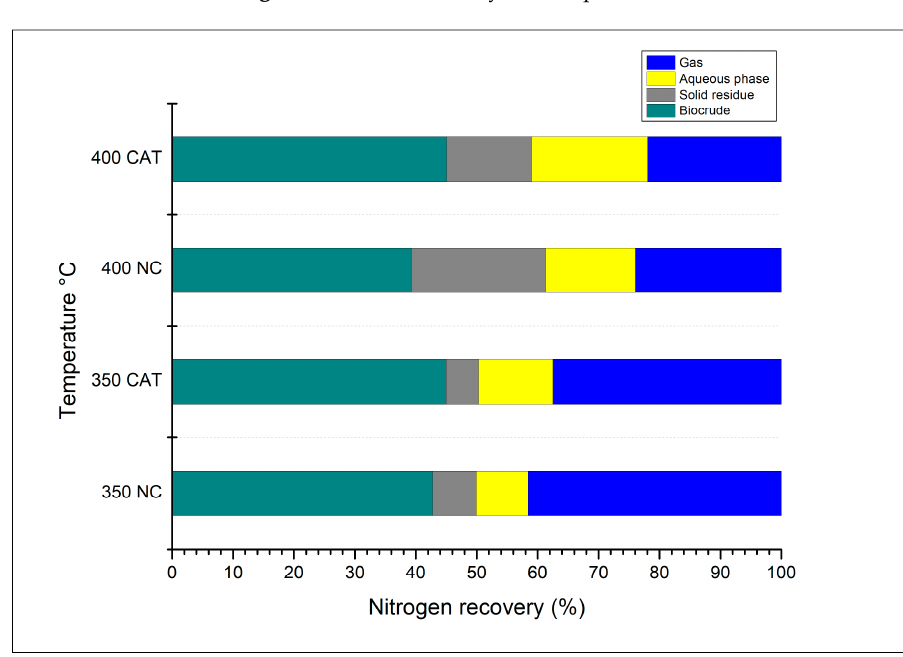
Energies 2020 , 13 , x FOR PEER REVIEW Figure 4. Carbon recovery in HTL products. Figure 4. Carbon recovery in HTL products.